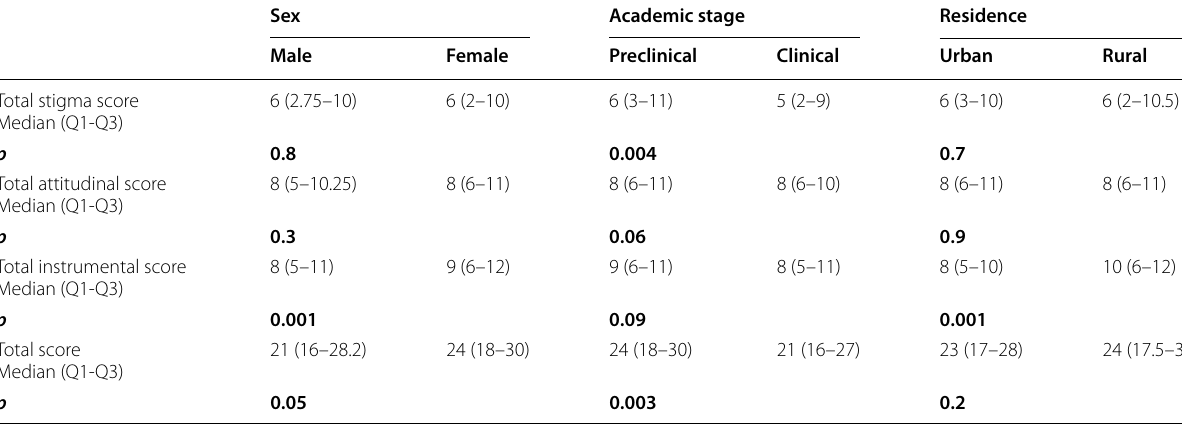
Table 2 Variation of total scale and different subscales of (BACE) score according to sex, academic stage, and residence